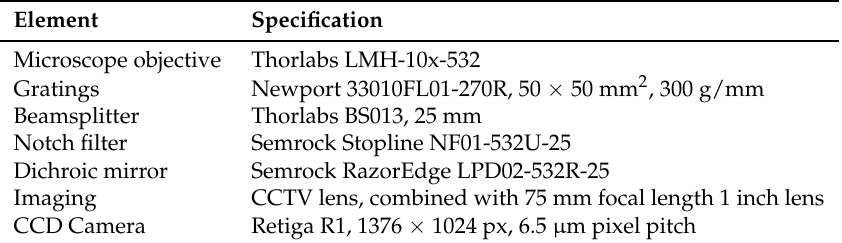
Figure 8. The experimental setup and the instrumentation for spatial heterodyne Raman spectroscopy: FM—folding mirror, FO—fiber optic, BS—beam splitter. Laser, modular dispersive spectrometer and the camera for SHRS are not shown. The photograph on the right corresponds to the box designated SHRS in the schematic. Table 1. Optical